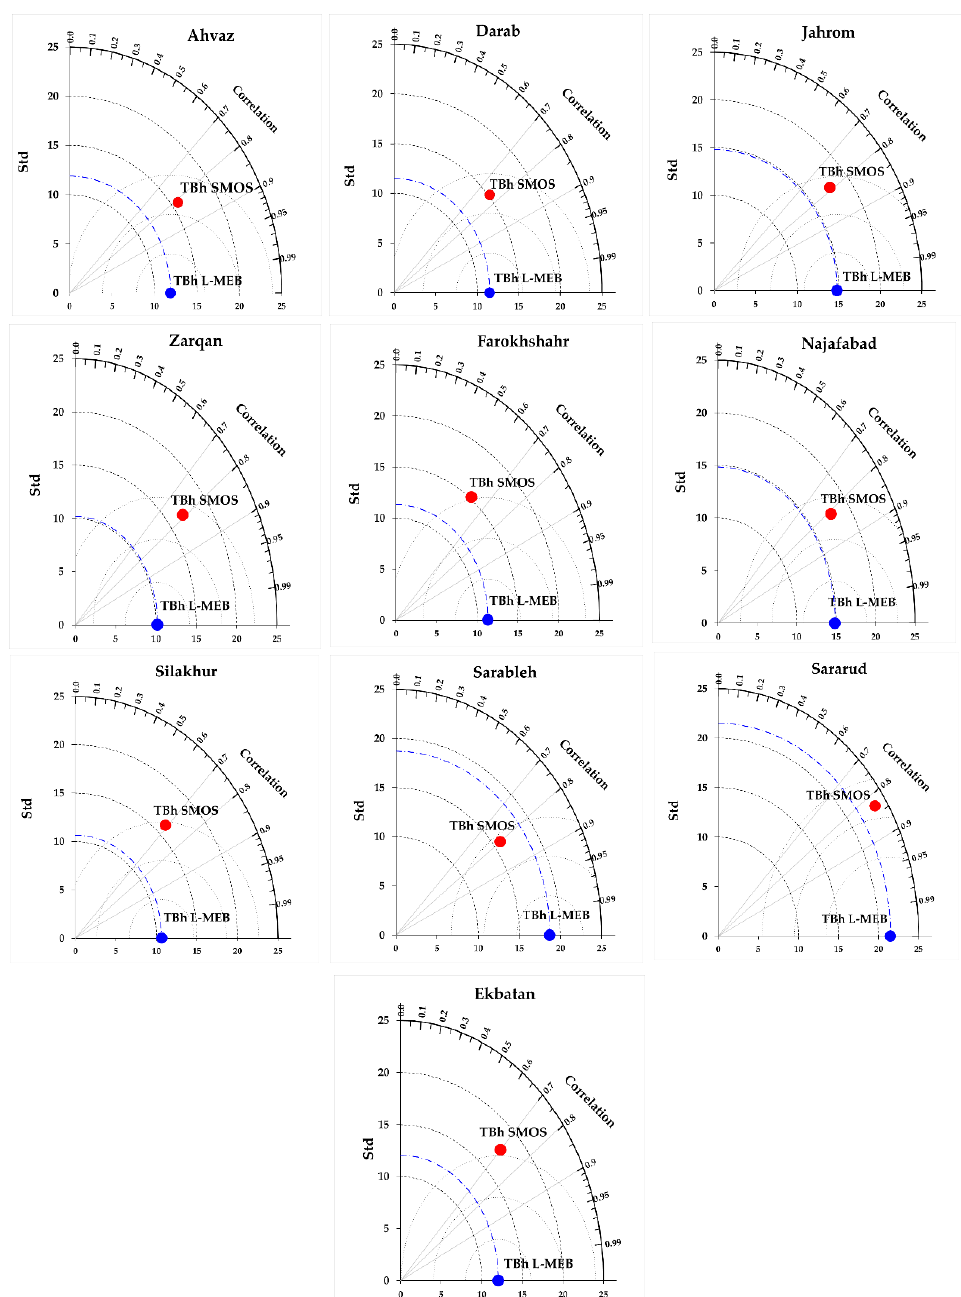
Figure 5. Taylor diagrams illustrating the statistics of the comparisons between TB H SMOS and TB H L-MEB data.